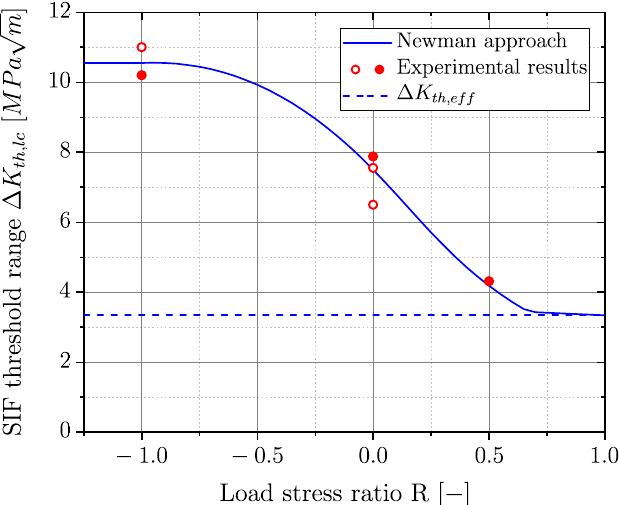
Figure 20. Experimental fatigue crack growth data compared to Newman’s